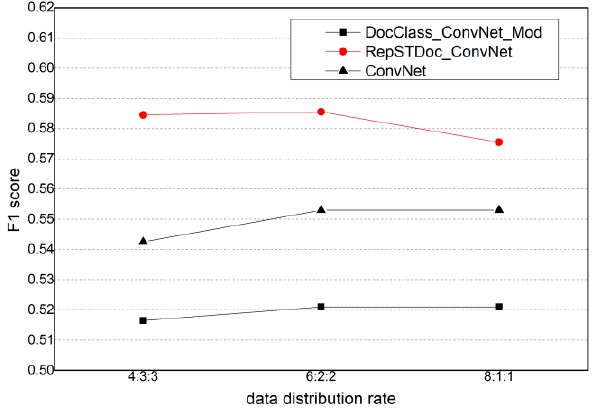
Figure 6. The effect of distribution